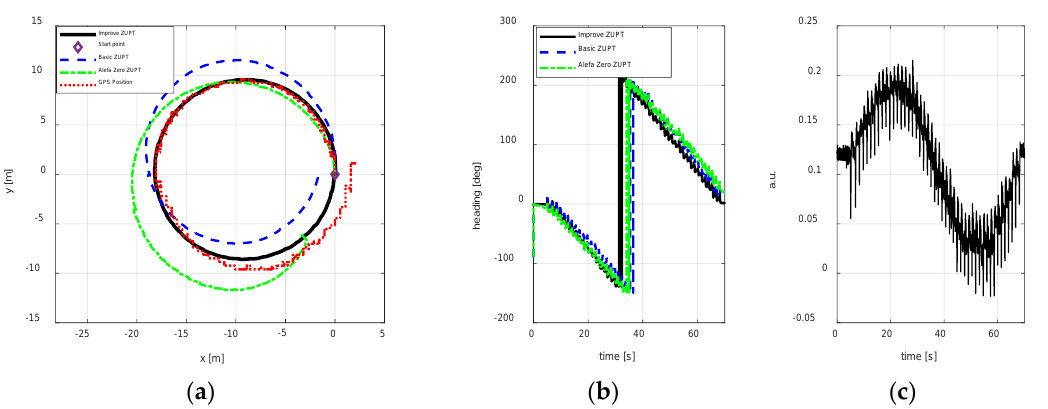
Figure 11. A circular path position result. ( a ) Trajectory; ( b ) Heading estimation result; ( c ) Magnetometer disturbances.